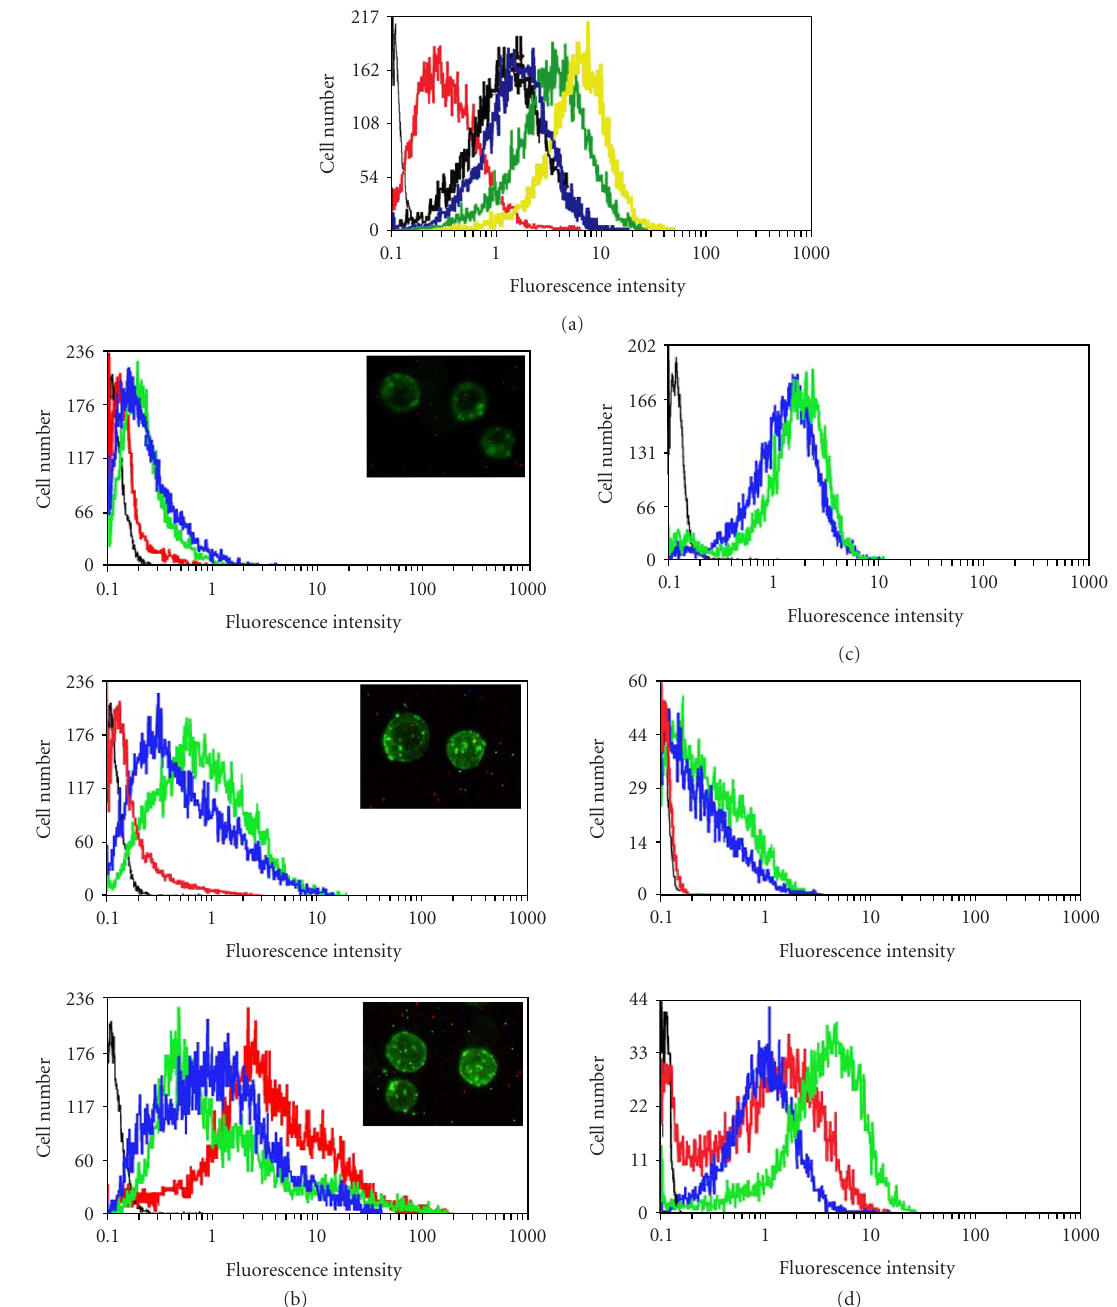
Figure 5. Profile of the binding of S100A8/A9 to MM46 cells in divalent cation-depleted medium, in standard medium or the presence of excess zinc. (a) Enhancement of the binding of S100A8/A9 to MM46 cells by zinc. The cells were incubated with 5 µ M S100A8/A9 in the divalent cation-depleted media supplemented with 1.25 µ M (red), 2.5 µ M (black), 5 µ M (blue), 10 µ M (green), or 20 µ M (yel- low) zinc sulfate at 37 ◦ C for 1h. (b) Kinetic changes in the binding profile of S100A8/A9. MM46 cells were incubated with 10 µ M S100A8/A9 for 30min (blue), 1h (green), or 3h (red) at 37 ◦ C in the defined divalent cation medium (upper panel), in the stan- dard medium (middle panel), or in the standard medium with 20 µ M zinc sulfate (lower panel). Insets: morphological appearance of MM46 cells incubated with 10 µ M S100A8/A9 for 1h in the defined divalent cation medium (upper), in the standard medium (middle), or in the standard medium with 20 µ M zinc sulfate (lower). The binding of S100A8/A9 on the fixed cells was visualized as described in “materials and methods.” (c) Binding of S100A9 to MM46 cells. The cells were incubated at 37 ◦ C with 10 µ M S100A9 for 1h (green) or 3 h (blue). (d) Changes in the profile of binding of S100A8/A9 to EL-4 cells. EL-4 cells were incubated in the standard medium (upper panel) or 20 µ M zinc sulfate (lower panel) with 10 µ M S100A8/A9 at 37 ◦ C for 30 min (blue), 1h (green), or 3 h (red). (a), (b), (c), and (d) black line: histograms of the control cells which were incubated without any sample for 1h in the respective